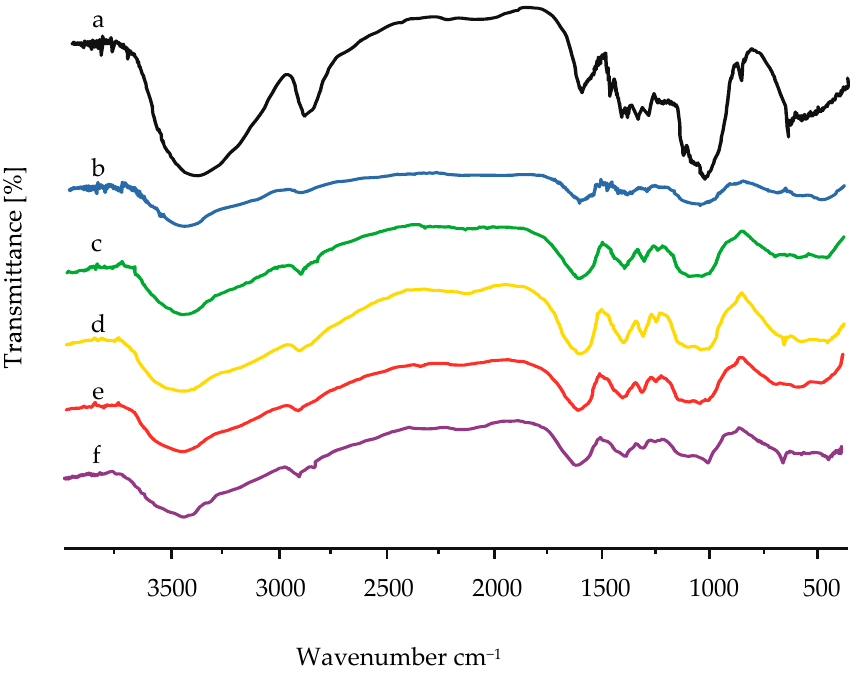
Figure 3. FTIR spectra of ( a ) cellulose, ( b ) CMC as synthesized with 20% ( w / v ) NaOH concentration, ( c ) CMC as synthesized with 30% ( w / v ) NaOH concentration, ( d ) CMC as synthesized with 40% ( w / v ) NaOH concentration, ( e ) CMC as synthesized with 50% ( w / v ) NaOH concentration and ( f ) CMC as synthesized with 60% ( w / v ) NaOH concentration.